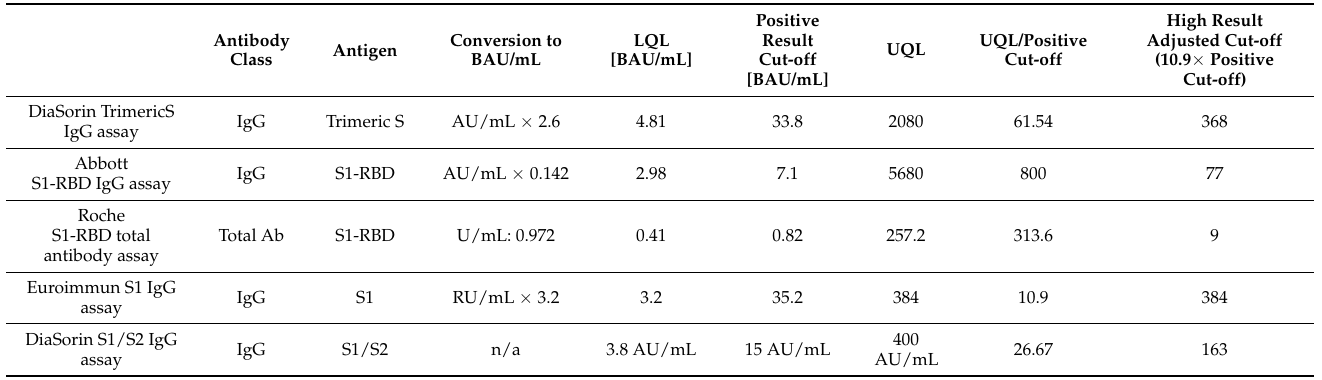
Table 1. The characteristics of 5 immunoassays